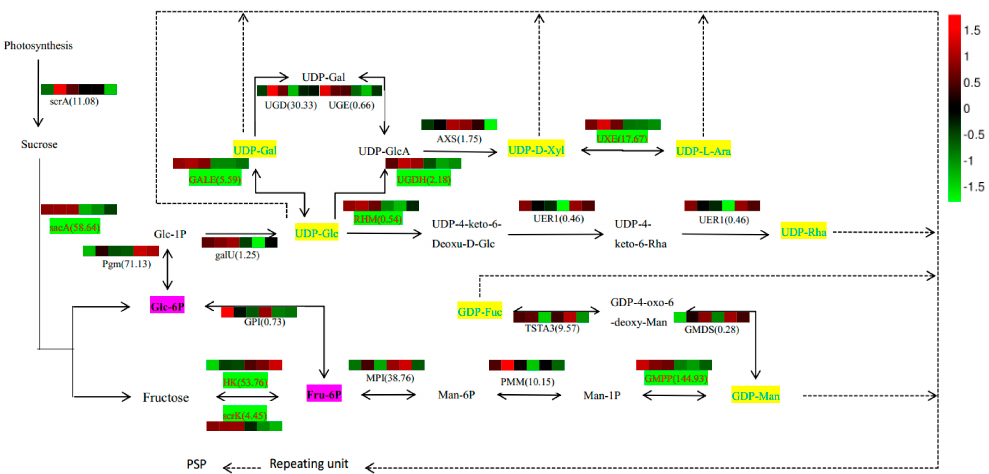
Figure 7. Proposed pathways for polysaccharide biosynthesis in Polygonatum sibiricum . Activated monosaccharide units, marked in blue with yellow background; key enzymes, marked in red with green background. Bolded text with pink background indicates key intermediates, while corresponding FPKM values are shown in brackets. Various color blocks represent logarithm of FPKM values. First three colors are SXLY samples; the latter three, HNLY samples. The real line arrows represent the identified enzymatic reactions, and the dashed line arrows represent multiple enzymatic reactions by multiple steps.